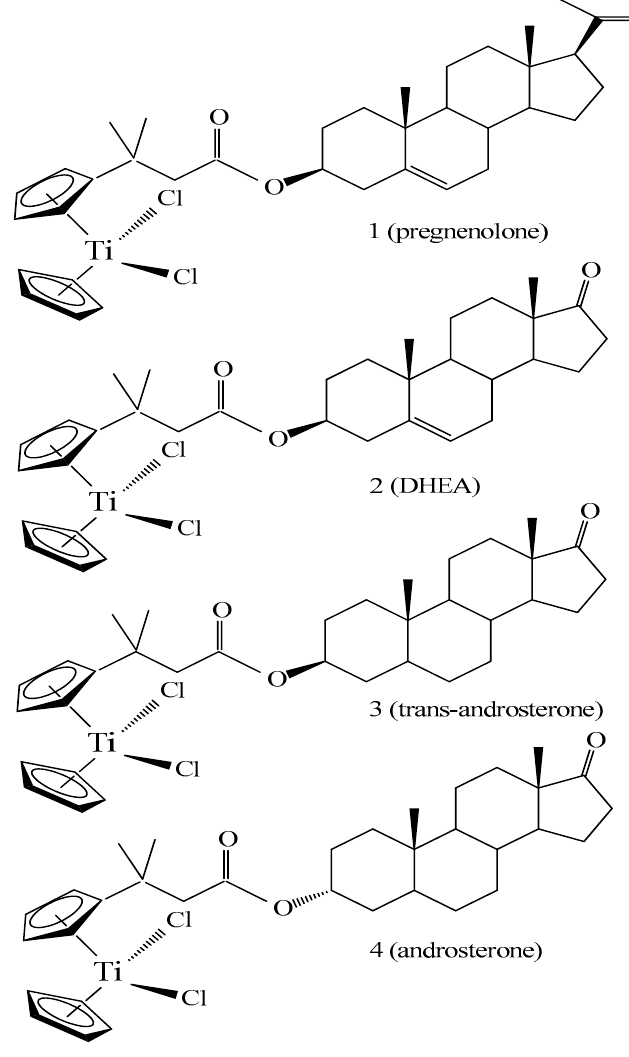
Figure 1. Steroid-functionalized titanocene dichlorides. Table 1. Selected bond distances and angles of steroid-functionalized